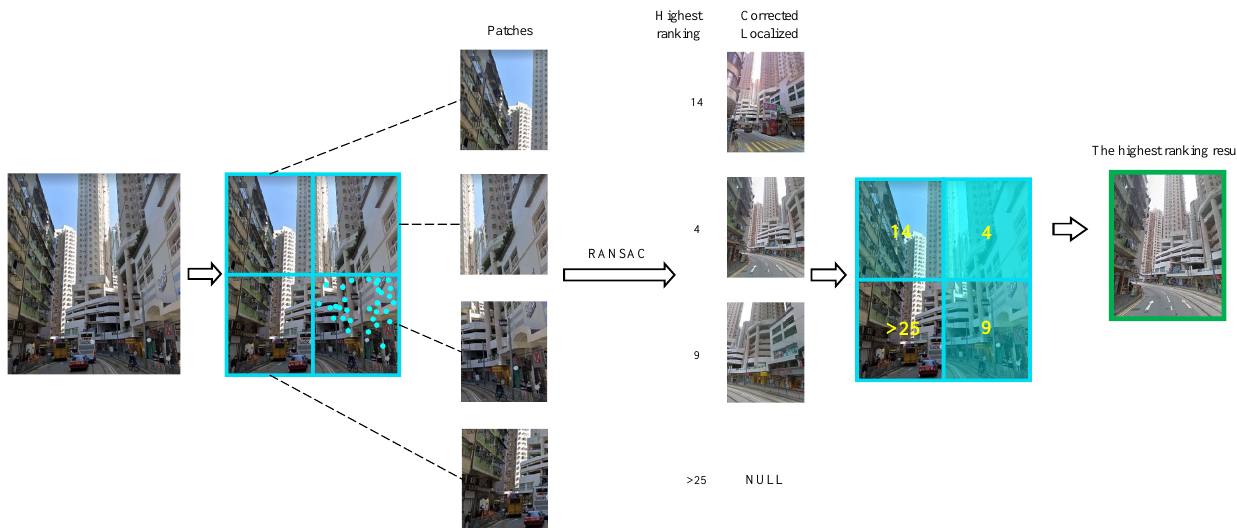
Figure 7. Schematic diagram of patch-region retrieval method. Take 4 partitions as an example: divide query image into 4 patch regions with 2 rows and 2 columns. Perform geometric verification on these regions in turn. Localization result, which can be correctly positioned and with the highest ranking in these areas, is used as positioning result of this query